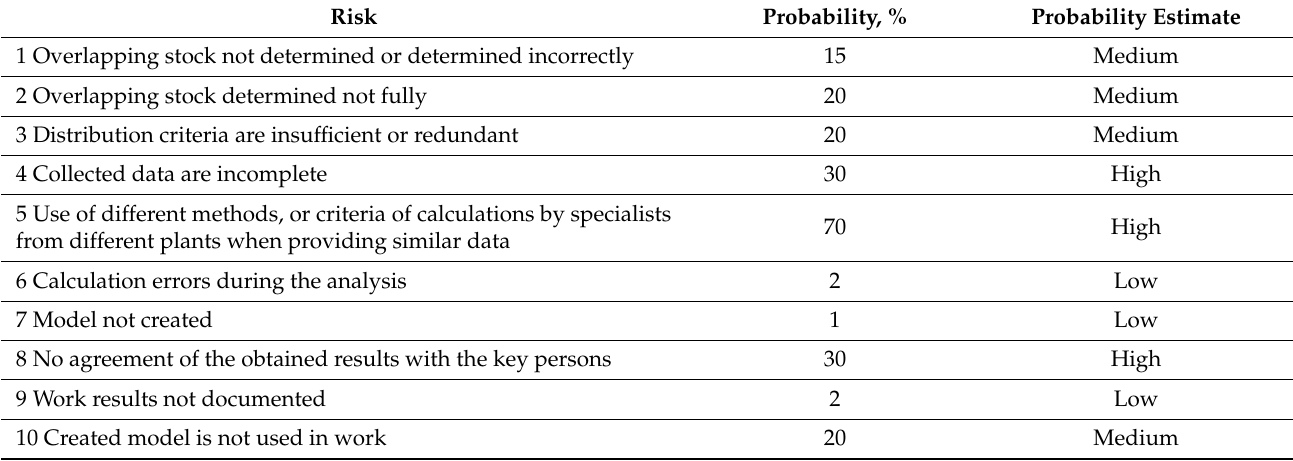
Table 4. Qualitative assessment of the risks of the process of “Developing a Model of Rolling Mill Loading with Orders with Overlapping Stock”.